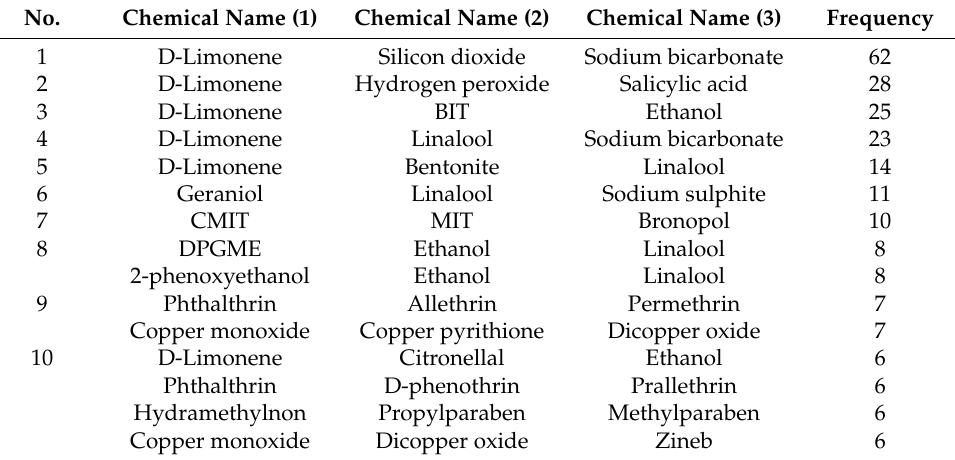
Table 4. Top 10 1 most frequently occurring ternary mixtures of biocides from combined inhalation exposure scenario database in South Korea.